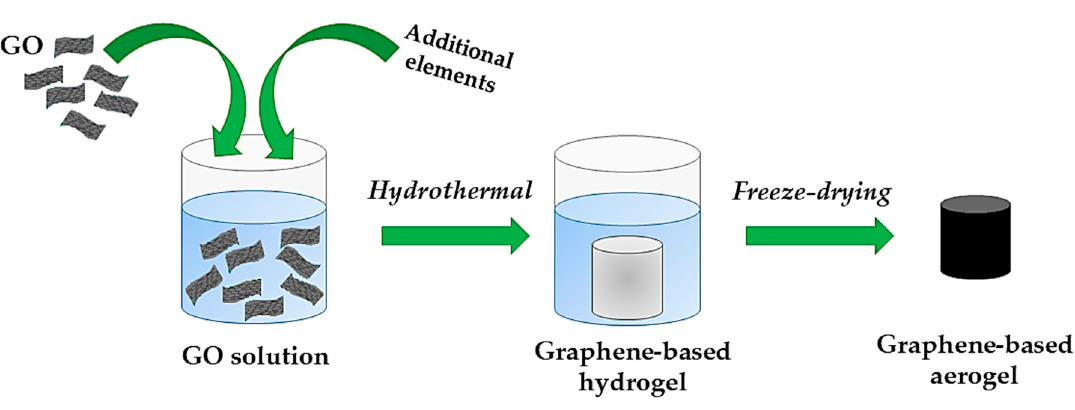
Figure 3. An exemplificative scheme of the GO-based aerogel’s synthesis via a hydrothermal method.